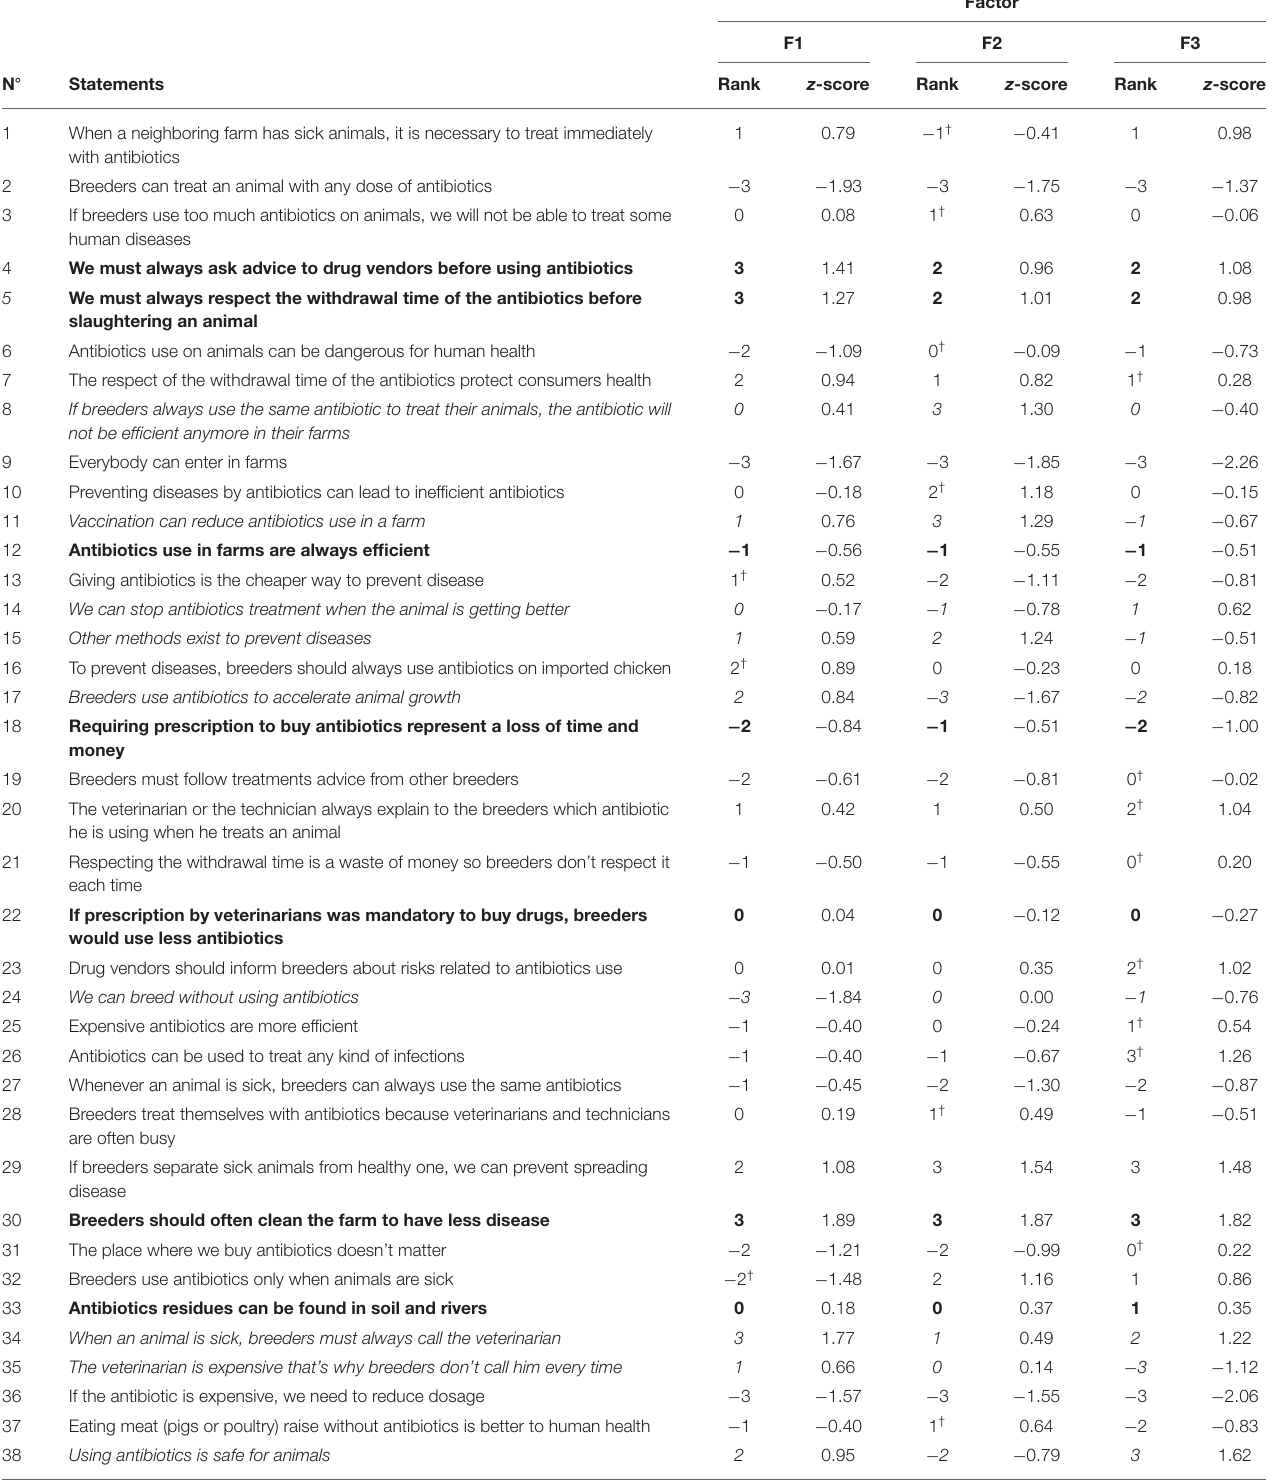
TABLE 2 | Q-set , rank and z-scores for the P-set